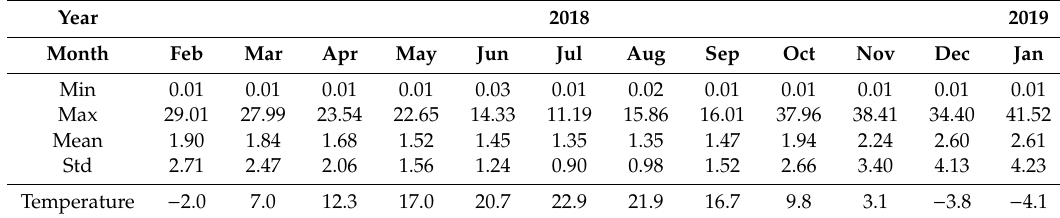
Table 1. The monthly statistic results of tropospheric NO 2 column concentration and temperature ( ◦